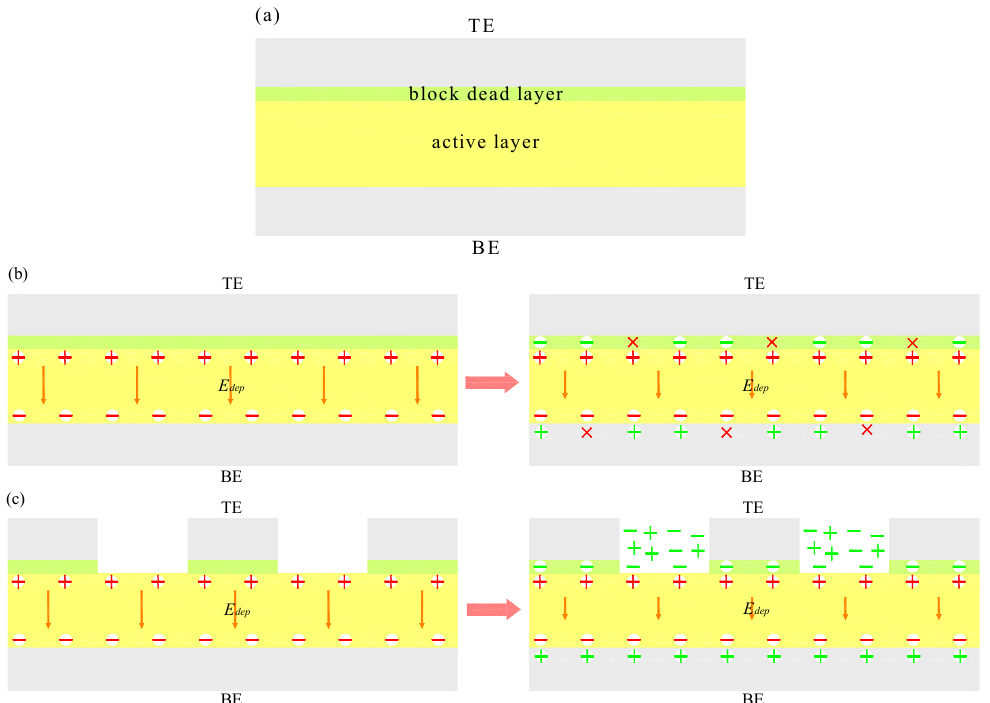
Figure 4. ( a ) Model of the ferroelectric capacitor with a P(VDF-TrFE) film including an active layer and a block dead layer. The top and bottom electrodes are indicated by TE and BE, respectively.